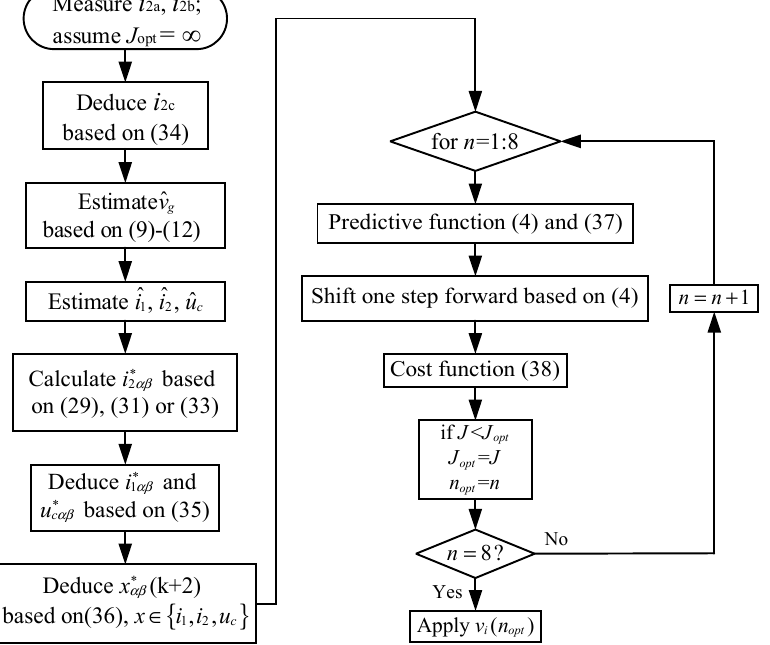
Figure 3. The flowchart of proposed FCS-MPC strategy .